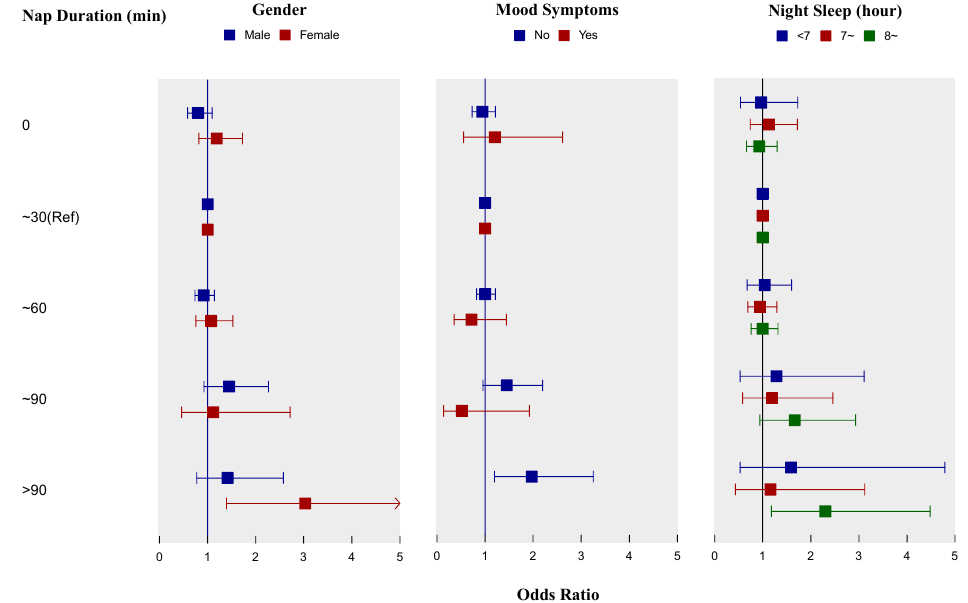
Figure 2. Subgroup analyses of associations between nap duration and prevalence of metabolic syndrome by logistic regression models according to gender, mood symptoms, and night sleep hours. All three models were adjusted for age, affiliation, marital status, position level, smoking status, drinking status, physical activity, bedtime at night, use of sleeping medicine, and sleep quality, and were adjusted for gender, mood symptoms, and night sleep duration as appropriate. In subgroup analysis of participants with mood symptoms, the odds ratio for group of >90 min was absent because no participant in this group had metabolic syndrome. Small squares represent the point estimates of odds ratios and horizontal lines represent 95% confidence intervals. Ref, reference. Int. J. Environ. Res. Public Health 2020 , 17 , x